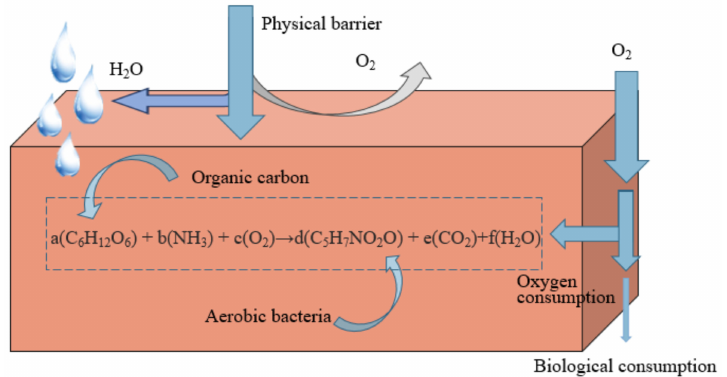
Figure 7. Schematic diagram of oxygen consumption coverage considering microbial